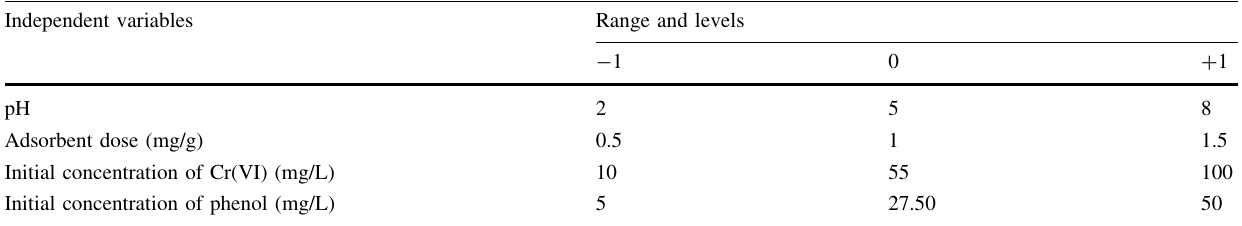
Table 5 Different levels of process variables selected for the simultaneous adsorption of Cr(VI) and phenol Independent variables